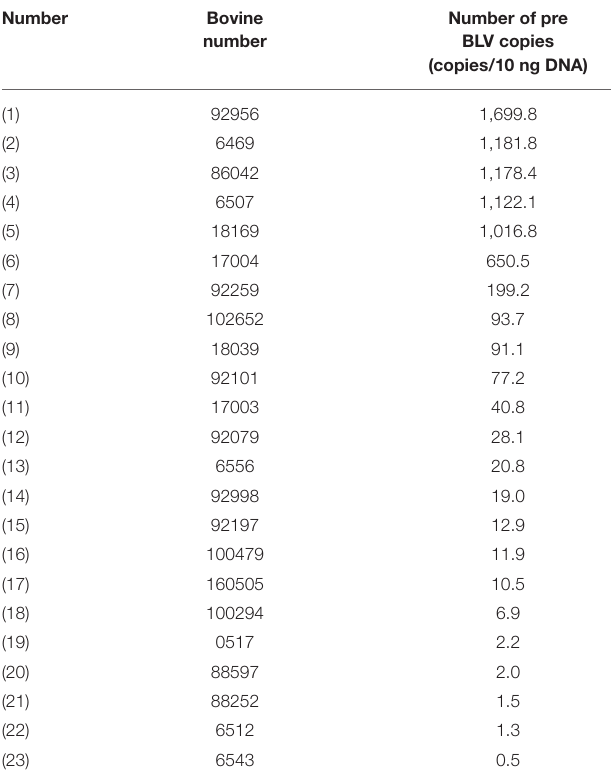
TABLE 3 | Sequences of the primers used for detection of cytokine.